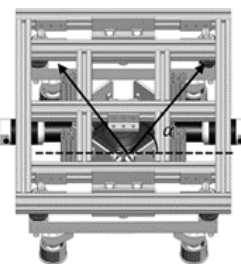
Figure 11. Inclined